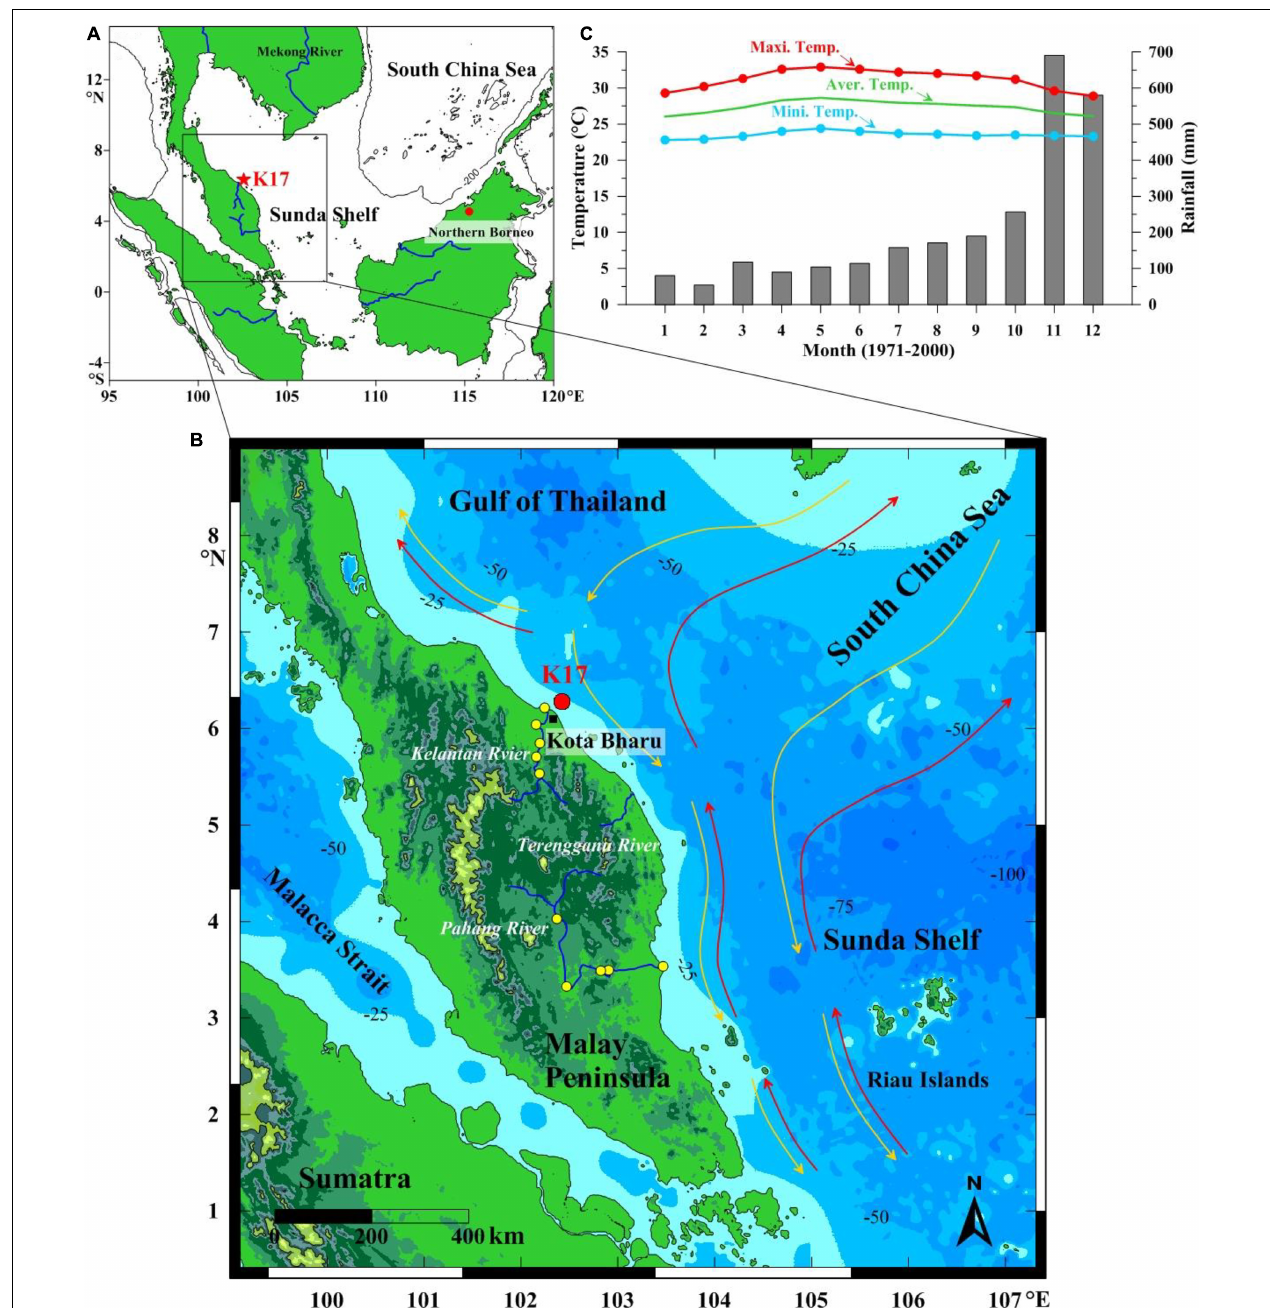
FIGURE 1 | (A) Locations of K17 (red star) and paleoclimate records from stalagmites (red dots) referenced in the text: Northern Borneo (Partin et al., 2007). (B) Geographic setting and prevalent hydrography of the western Sunda Shelf. Hydrography was modified from Tangang et al. (2011). The red and yellow arrows show the southwest and northeast monsoon currents, respectively. The locations of Core K17 and Sr-Nd sites of Kelantan and Pahang rivers are exhibited by red dot and yellow dots, respectively. (C) Regional monthly average precipitation (gray bars) and temperature over Kota Bharu from 1971 to 2000. Temperature and rainfall data are from the World Weather Information Service